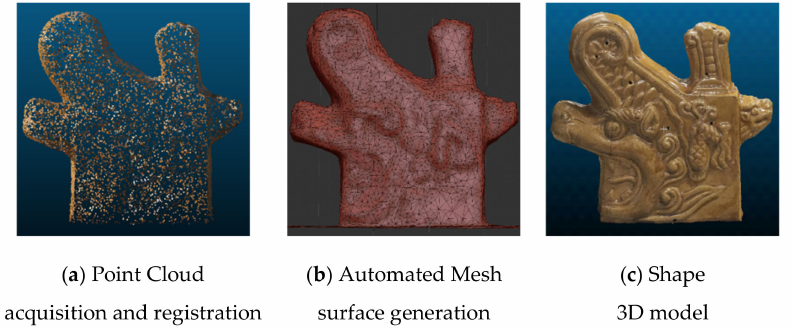
Figure 4. The workflow of decorative component reconstruction ( Wen shou ).